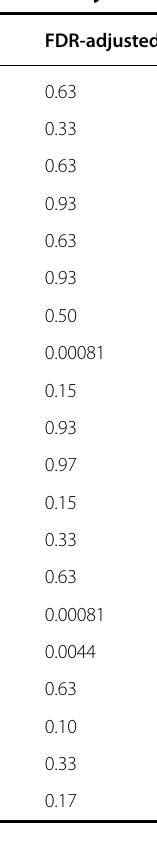
Table 3 Association of clinical features and selected metabolite factors with diabetes remission at 2 and 4/5 years.